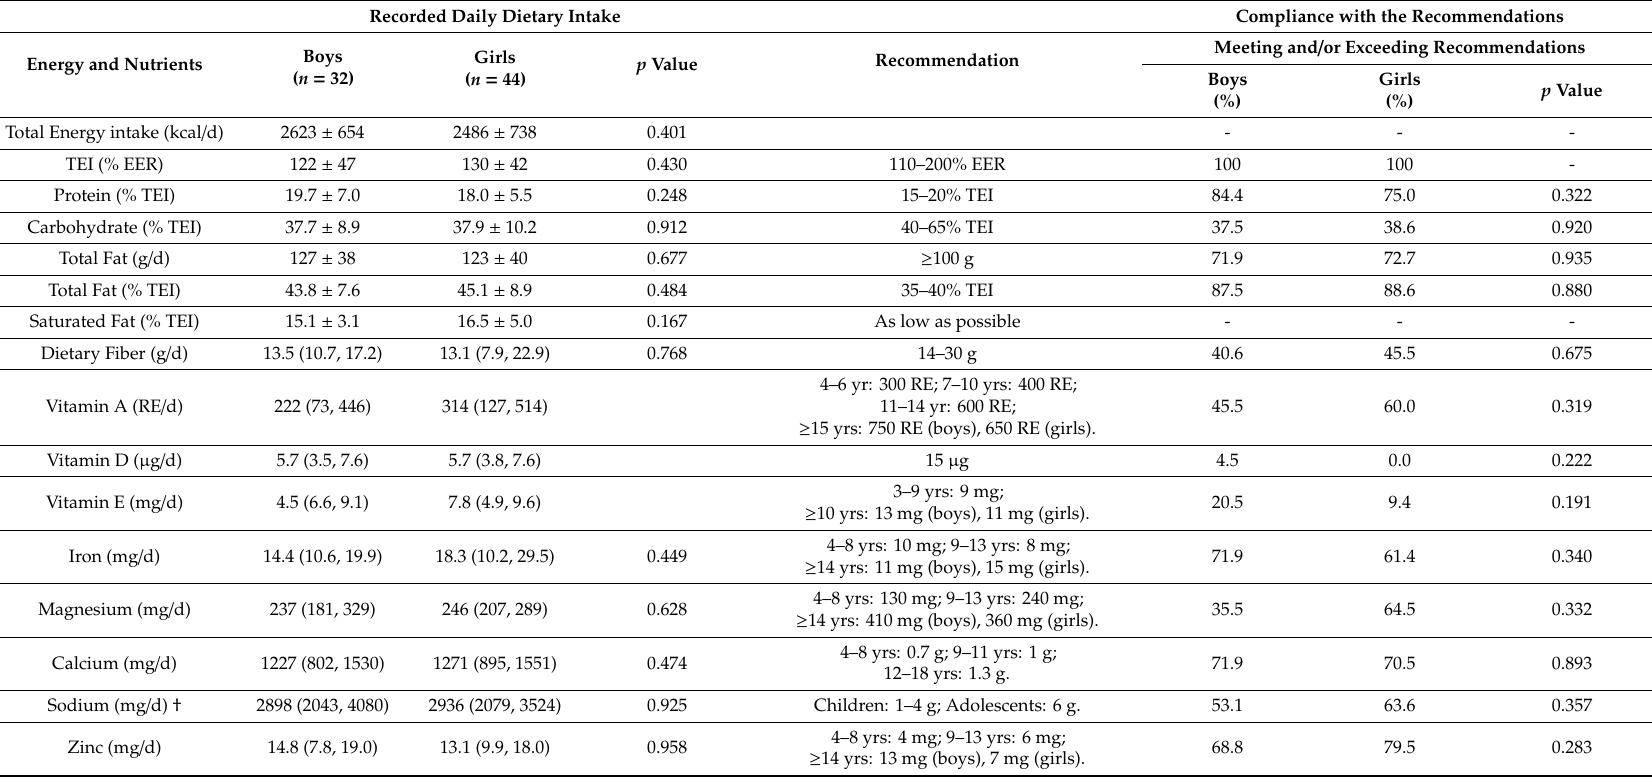
Table 2. Dietary assessment of girls and boys with cystic fibrosis and compliance with the recommendations